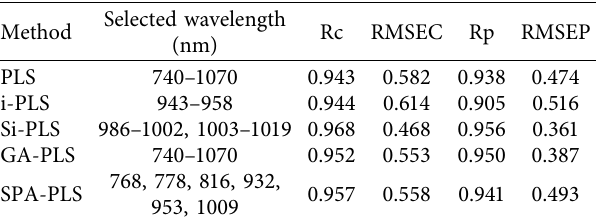
Figure 4: SGD1-SiPLS score plot of measured versus predicted moisture content (a) and residuals versus samples (b). Table 5: Optimum comparison of model performance for diferent variable selection